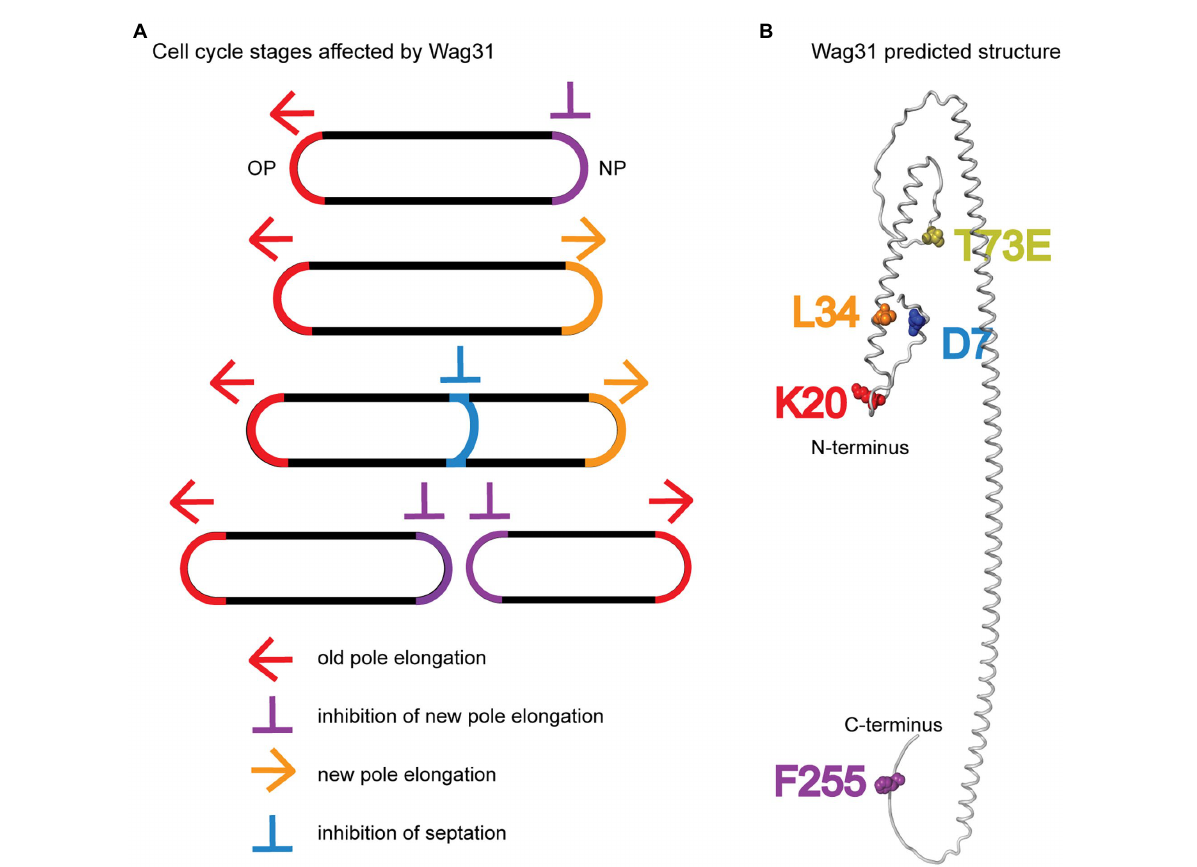
FIGURE 7 Models. (A) Multiple stages of the cell cycle affected by Wag31 are highlighted. (B) Alphafold2 predicted structure (Jumper et al., 2021) of a Wag31 monomer, with residues of interest